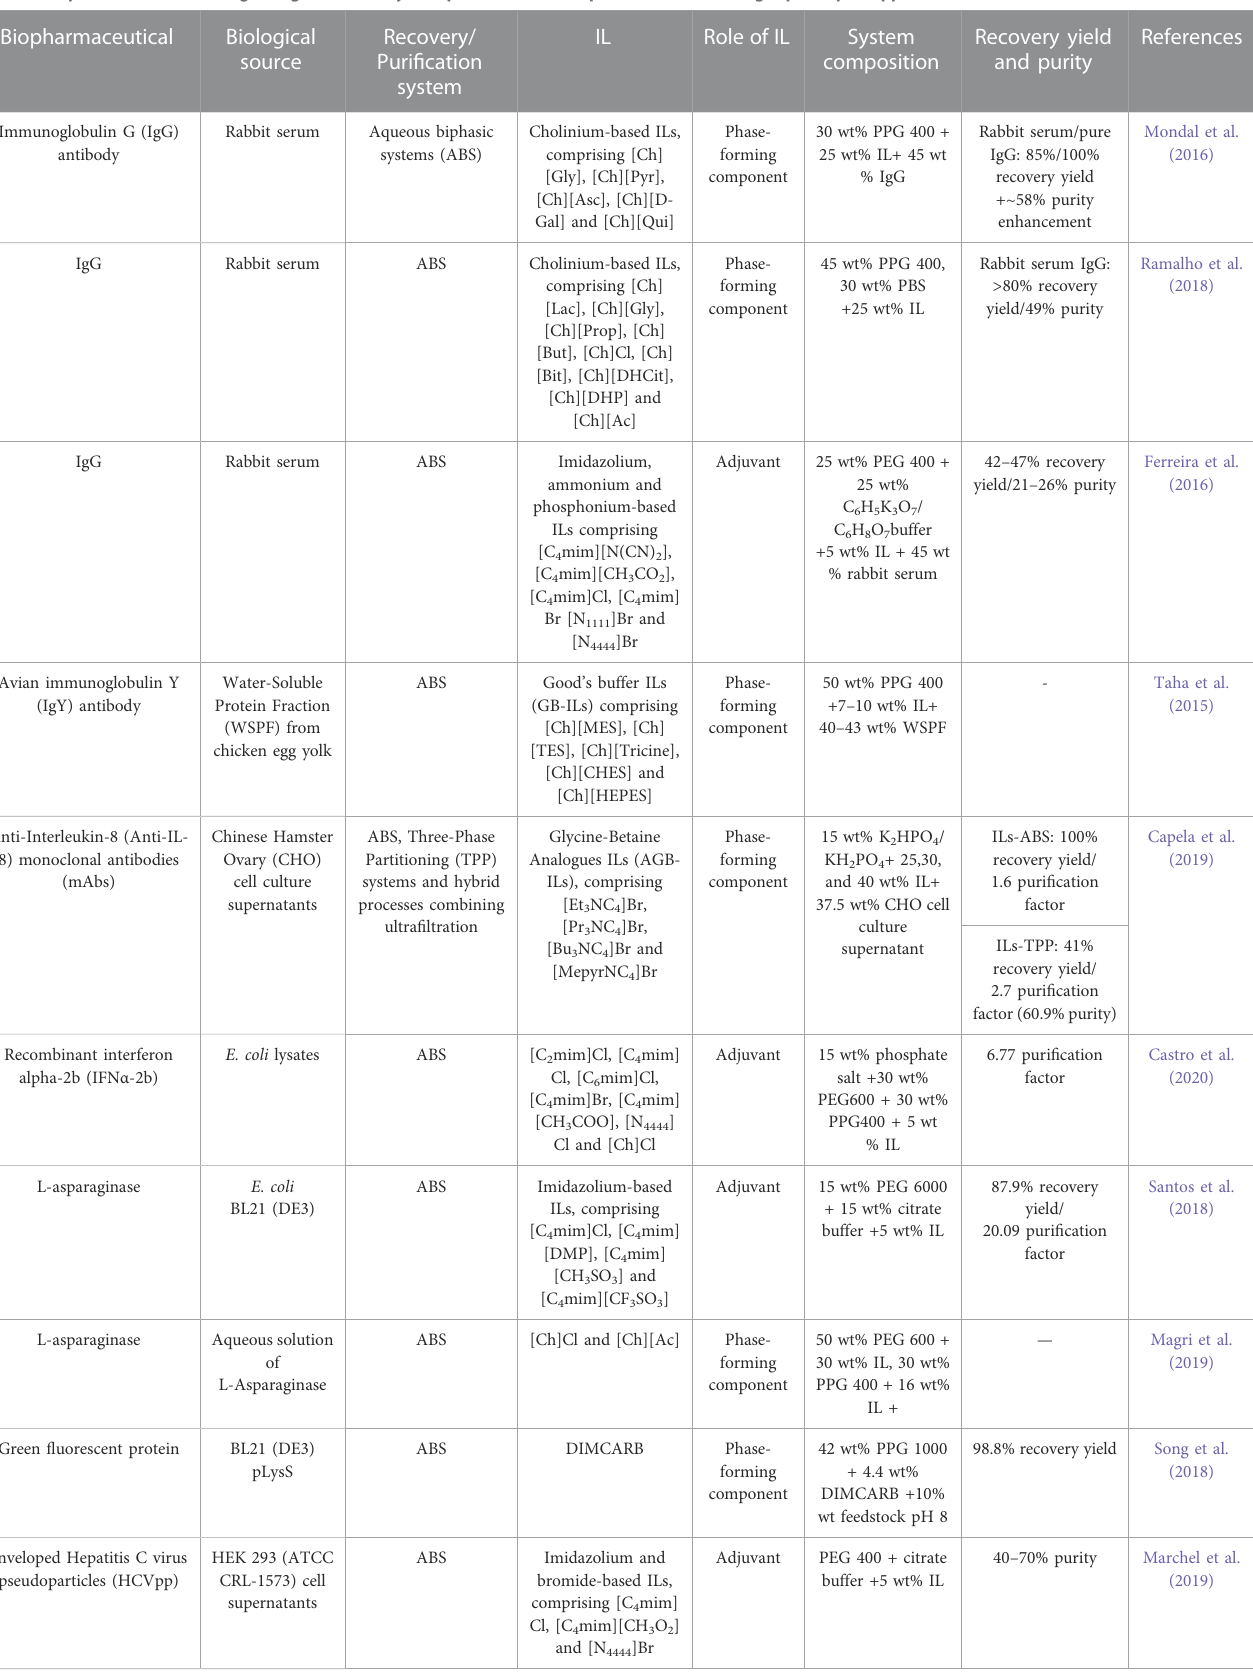
TABLE 1 Representative works regarding the recovery and puri fi cation of biopharmaceuticals using liquid-liquid approaches based on ILs. Biopharmaceutical